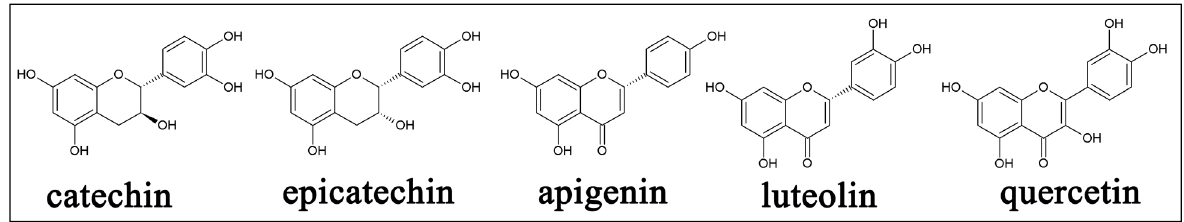
Figure 8. Chemical markers of Rumex vesicarius